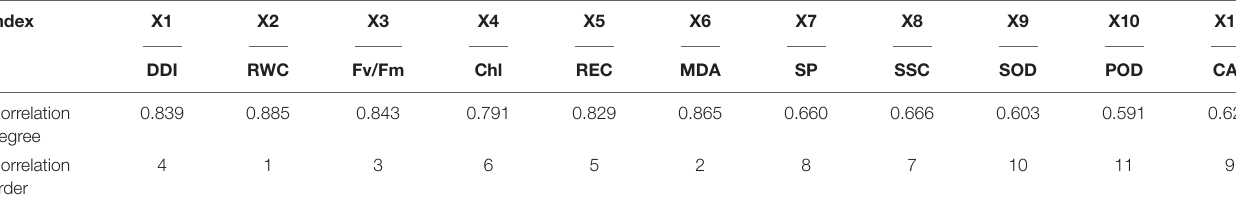
TABLE 5 | Gray correlation analysis between the identification indices and D